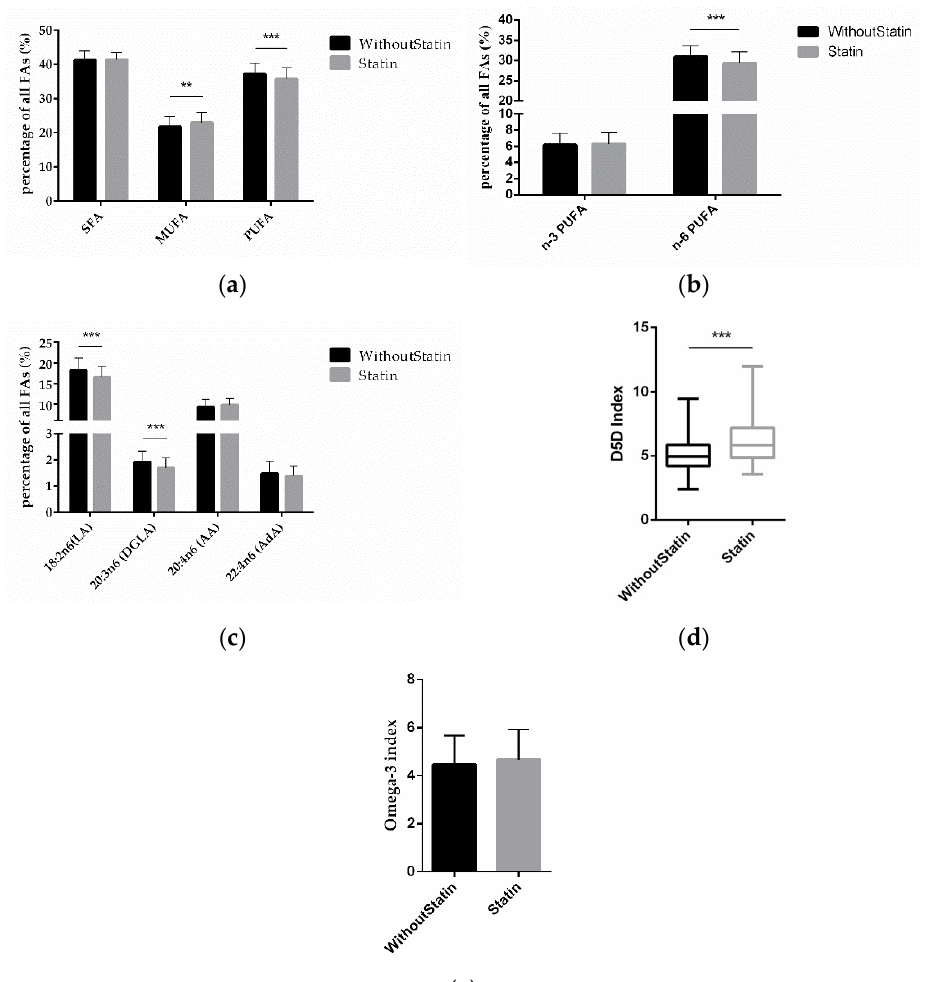
Figure 3. Correlation of FAs and statin treatment. ( a ) Relative content of SFAs, MUFAs, and PUFAs depending on statin treatment vs. no statin treatment. ( b ) Relative content of n-3 and n-6 PUFAs according to statin treatment. ( c ) Relative content of different n-6 PUFAs according to statin treatment. ( d ) D5D index and ( e ) omega-3 index according to statin medication. ( n = 142 for the without-statin group, n = 112 for the statin group; ** indicates 0.001 < p < 0.01, *** indicates p < 0.001).